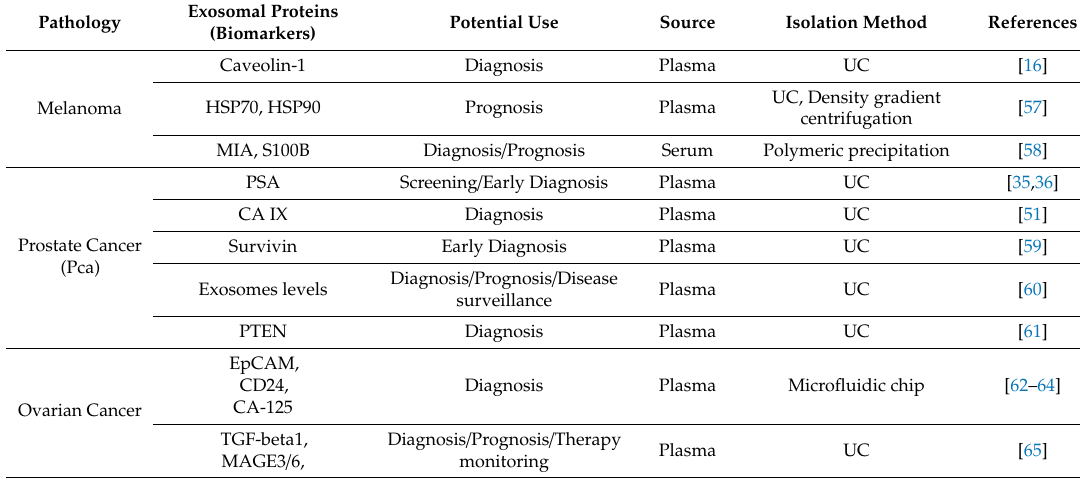
Table 1. Protein tumor markers on plasmatic